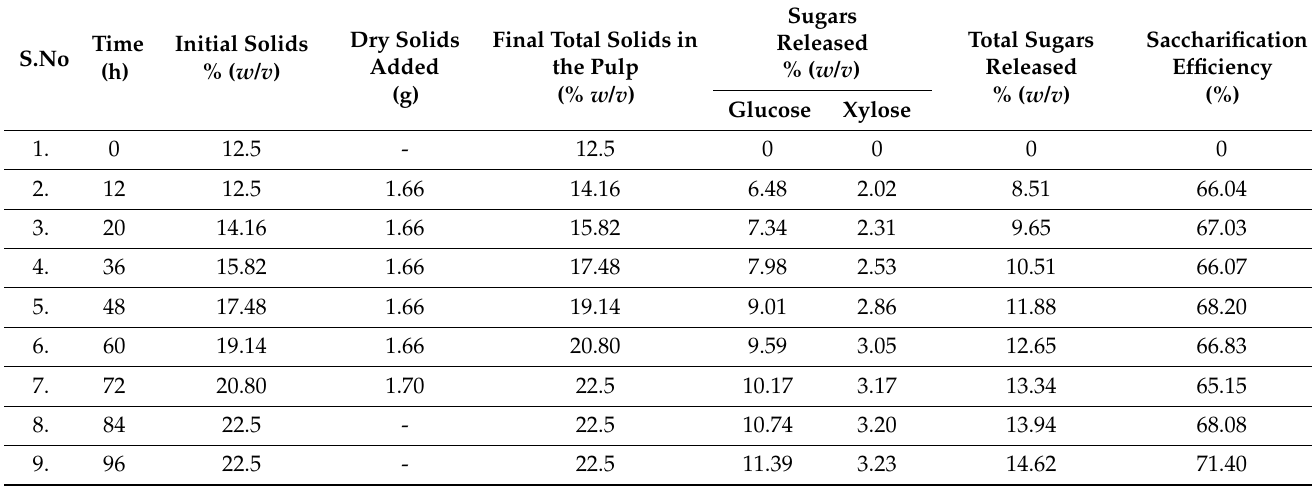
Table 3. Fed-batch saccharification with 3.75 FPU/g DS Cellic CTEC 3